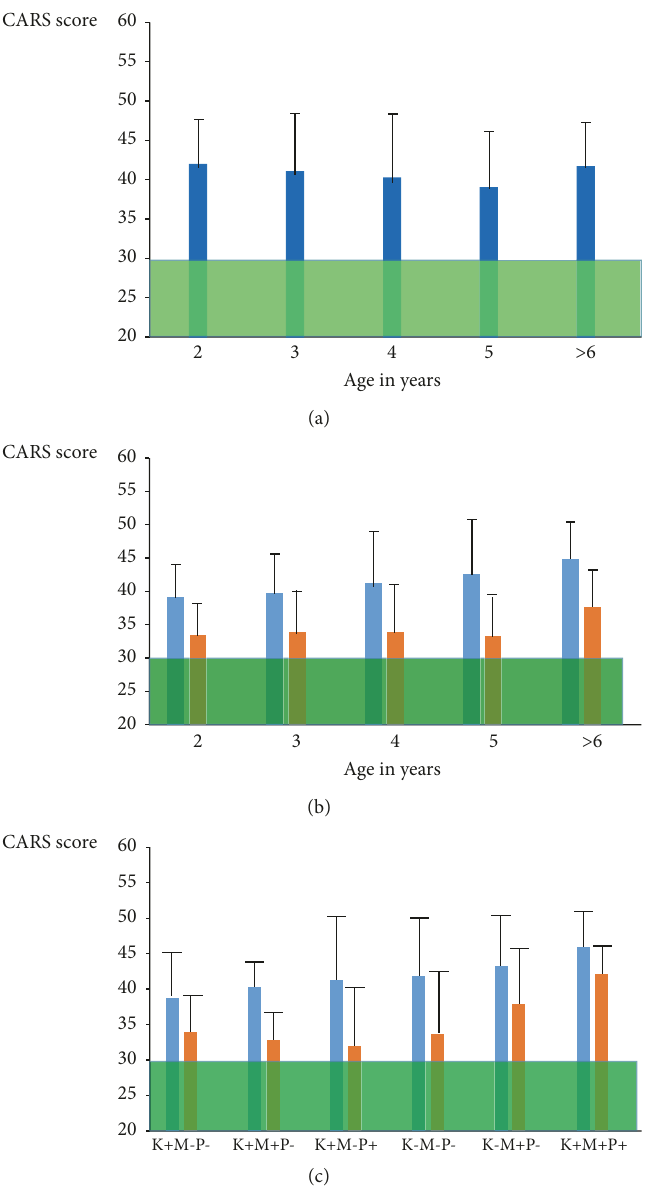
Figure 1: The upper figure (a) shows the plotted CARS with age for 84 untreated patients. The middle figure (b) shows the effect of treatment among 82 treated patients (blue bars represent CARS at baseline and orange bars the CARS after two years treatment). Figure (c) represents the treatment results among different groups with FR autoantibodies in the child (K), mother (M), or father (P).